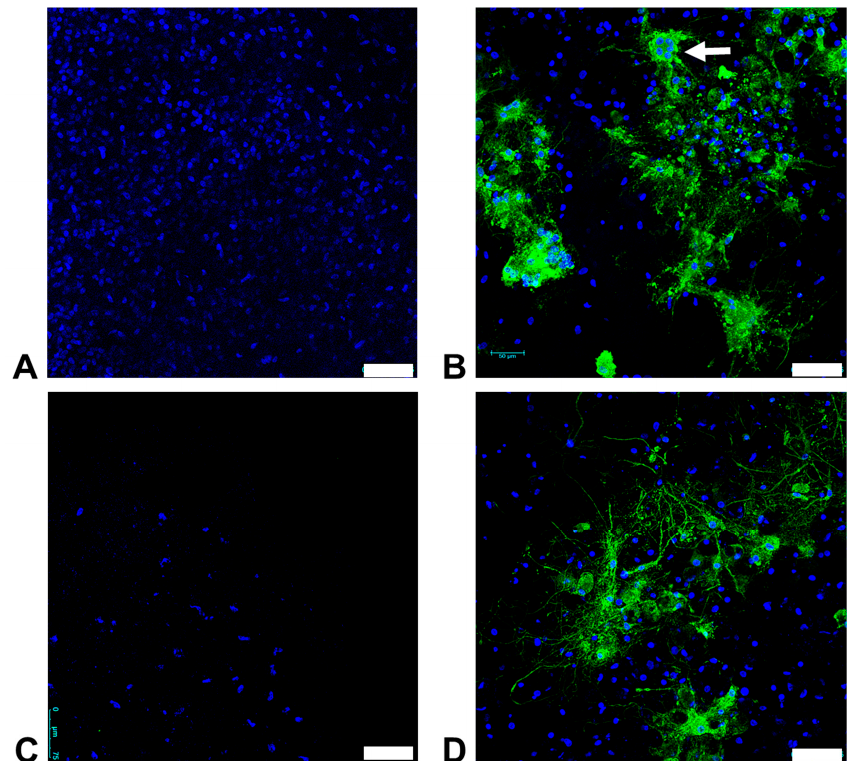
Figure 8. Susceptibility of feline organotypic brain slice cultures to FeMV-GT2. A representative staining result from the cerebellum (A and B) and from the Cerebrum (C and D) is shown. After 17 days in culture the slice was infected with 1800 FFU of FeMV-GT2-Gordon strain or mock-infected. At day 10 p.i. slices were fixed and stained with an α -FeMV-nucleoprotein antibody (shown in green). Cell nuclei were stained with DAPI (shown in blue). Note the formation of small syncytia in the cerebellum (white arrow), ( A , C ) Mock infection; ( B , D ) FeMV-GT2-infection. Scale bars indicate 75 µ